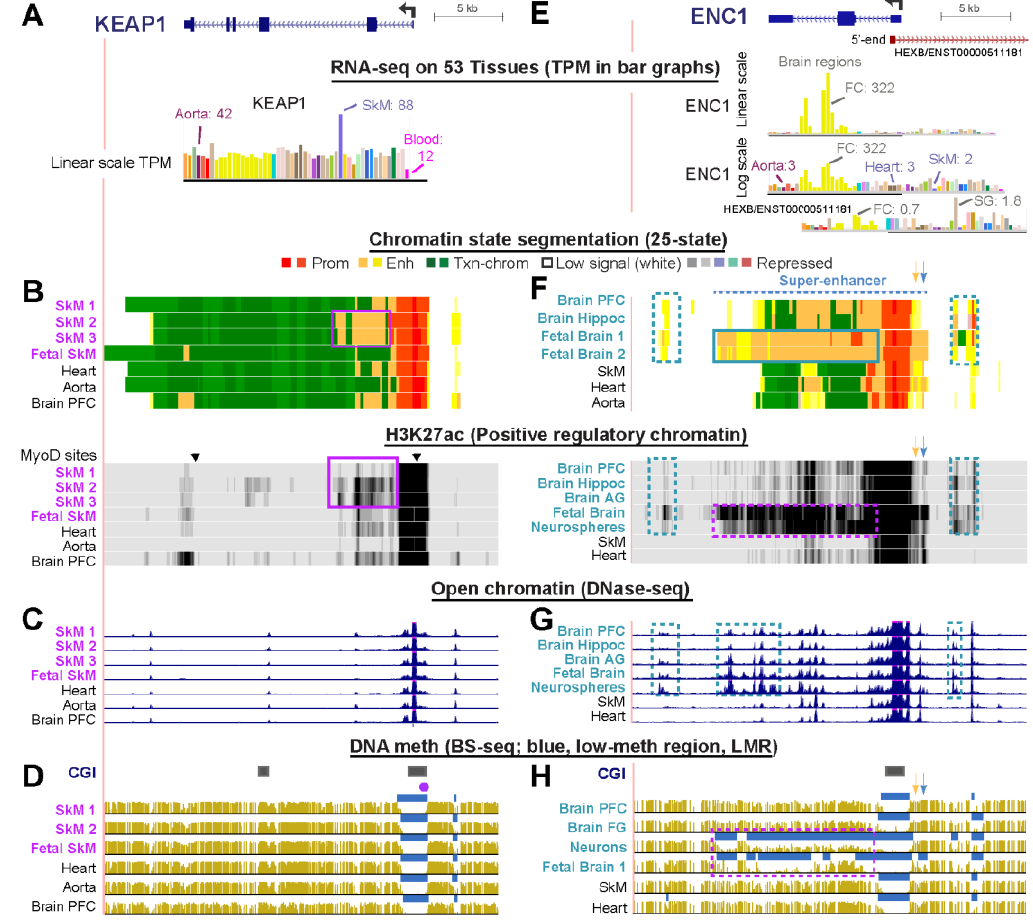
Figure 3. Epigenetic profiles for KEAP1 / KLHL19 and ENC1 / KLHL37 , which encode critical proteins that bind to NRF2 and regulate adaptation of cells to oxidative stress. ( A – D ) KEAP1 (chr19:10,591,087-10,619,523) and ( B – H ) ENC1 (chr5:73,908,815-73,950,517). Tracks are shown as in Figure 1. SkM 1 refers to psoas muscle while SkM 2 and SkM 3 are SkM from upper leg [4,15]. Boxed regions are tissue-specific epigenetic marks; orange and blue arrows are previously reported human phenotype-linked hypomethylated CpG sites described in the text. FC, frontal cortex; SG, salivary gland; PFC, prefrontal cortex; Hippoc, hippocampus; AG, angular gyrus; FG, frontal gyrus.